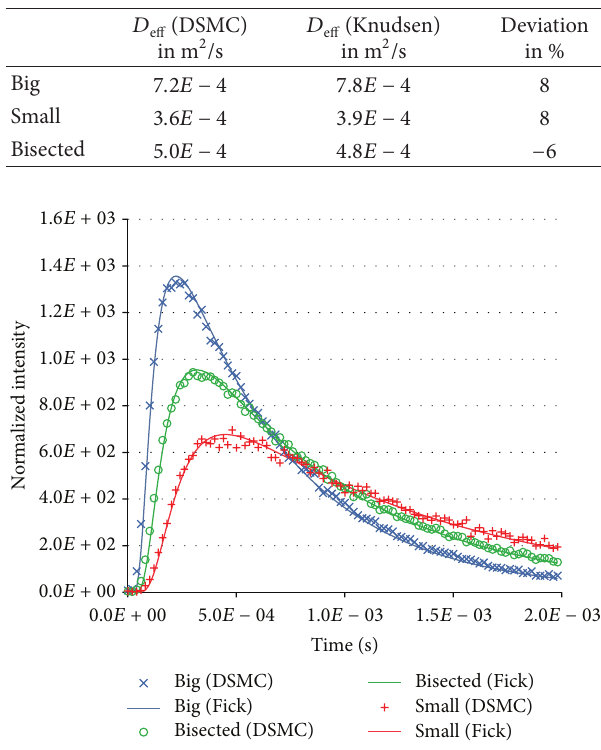
Table 1: Effective diffusion coefficients from DSMC and theoretical calculations.